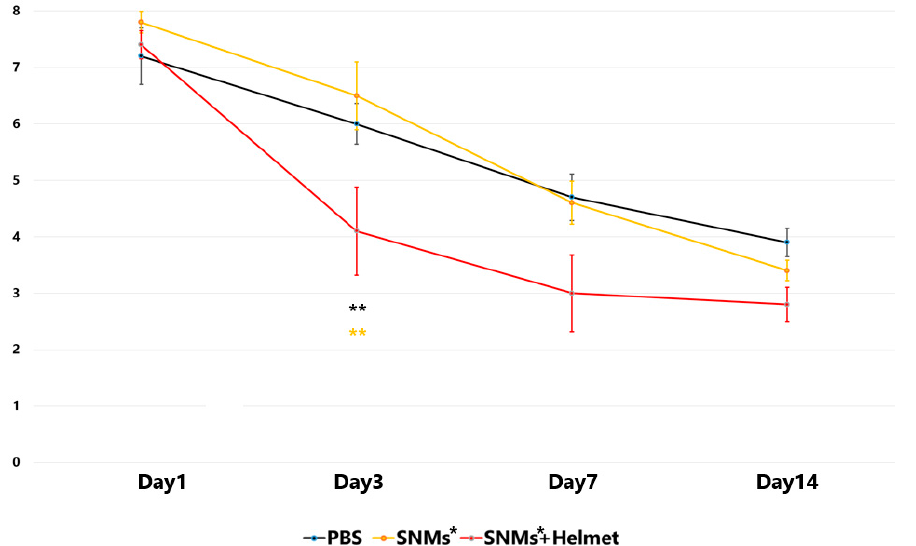
Figure 10. Behavioral functional tests were regularly performed for 2 weeks after the induction of ICH. The results of each group are represented by different color dots: black line, PBS group; yellow line, SNMs* group; red line, SNMs*+Helmet group. On day 3 after ICH, the rats in the SNMs*+Helmet group improved limb placement function compared with those in the PBS or SNMs* groups. (** p < 0.005; n = 6 for each group).